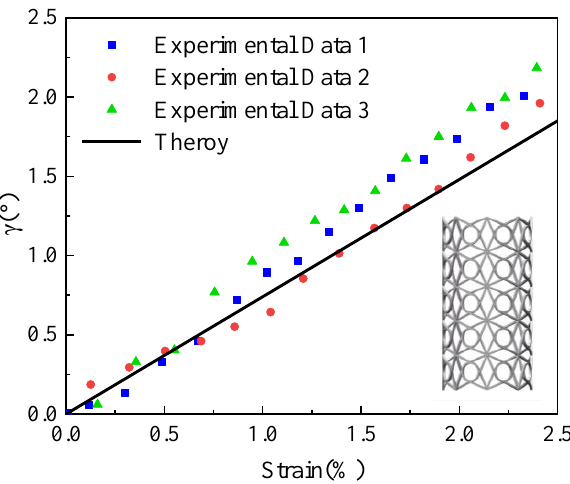
Figure 12. Three-dimensional cylindrical shell compression-torsion coupling deformations of chiral